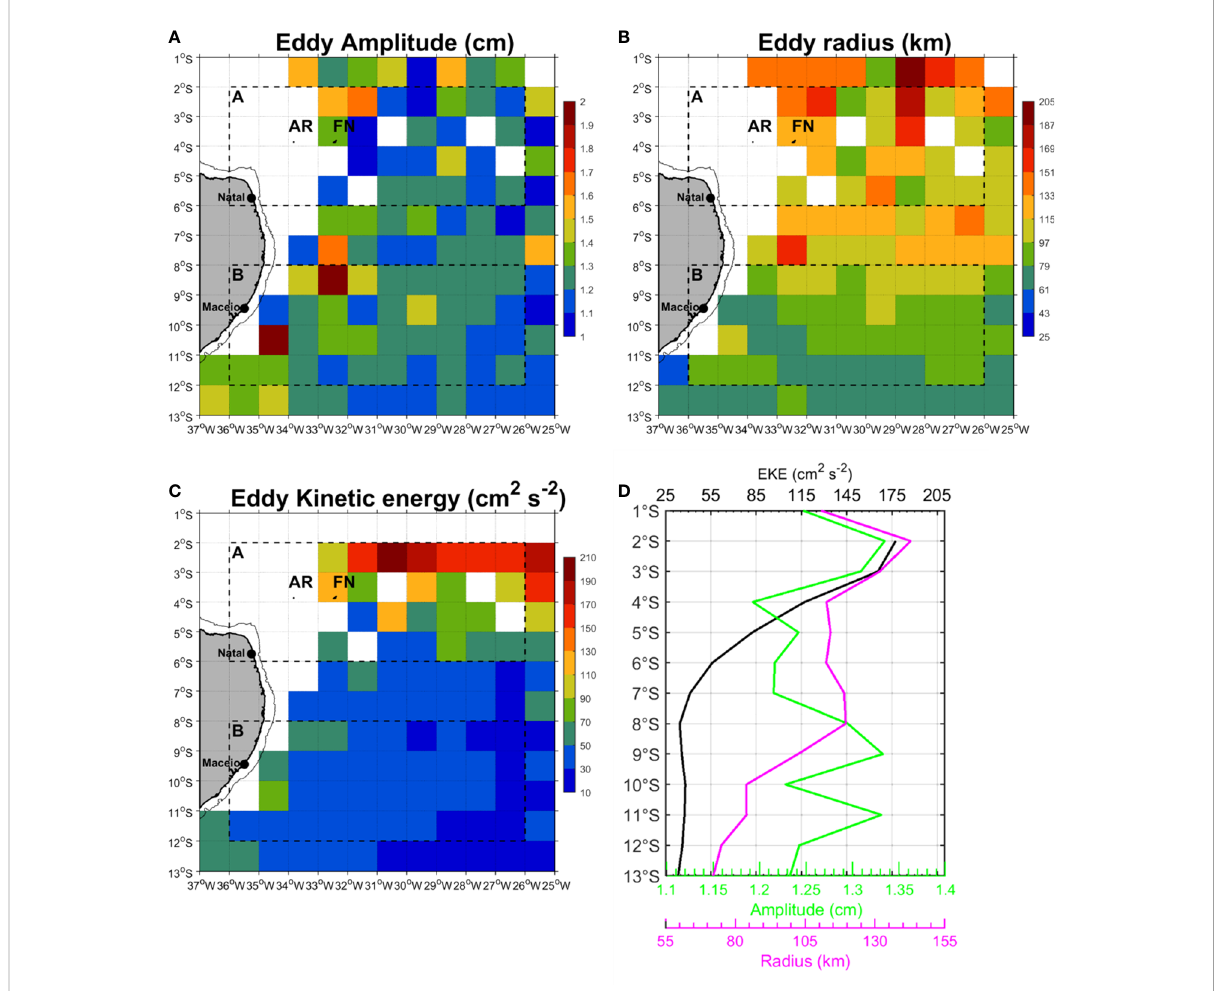
FIGURE 3 Spatial distribution of mean eddy characteristics per degree square over 1993 -2018 period: (A) eddy amplitude (cm), (B) eddy radius (km), (C) eddy kinetic energy (cm 2 s -2 ) and (D) mean meridional variation of eddy